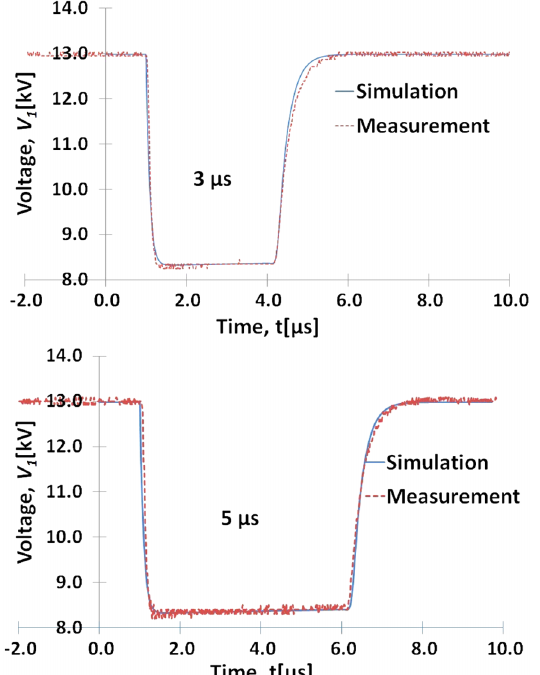
FIG. 9. IGUN simulation results for He 1 þ ions for the region between ECRIS exit and the end of the Einzel lens, where 10 kV and V 5 , 6, 8, 12, and 13 kV. V 0 ¼ 1 ¼